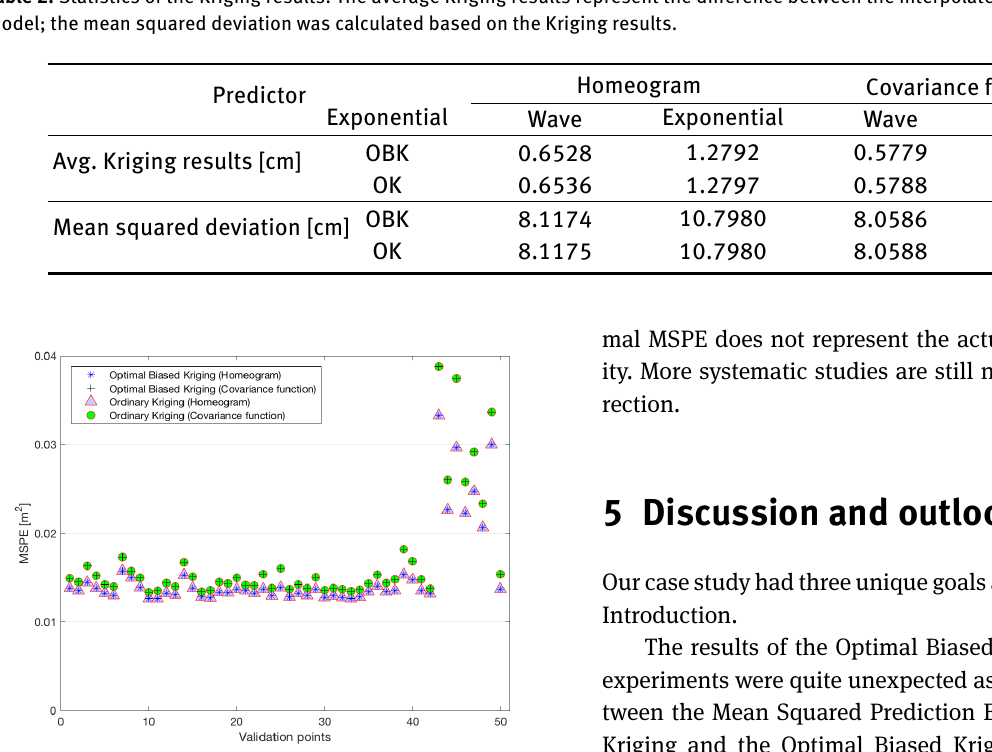
Figure 5: The MSPE of Optimal Biased Kriging and Ordinary Kriging at 50 validation points for the spatial coherency of homeogram and covariance function.